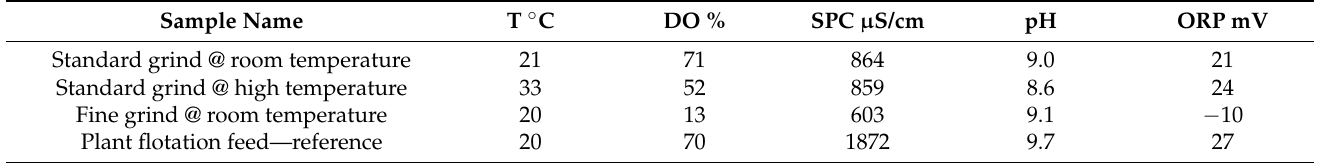
Table 2. Measured physicochemical parameters at the end of the sixth dissolution loop.